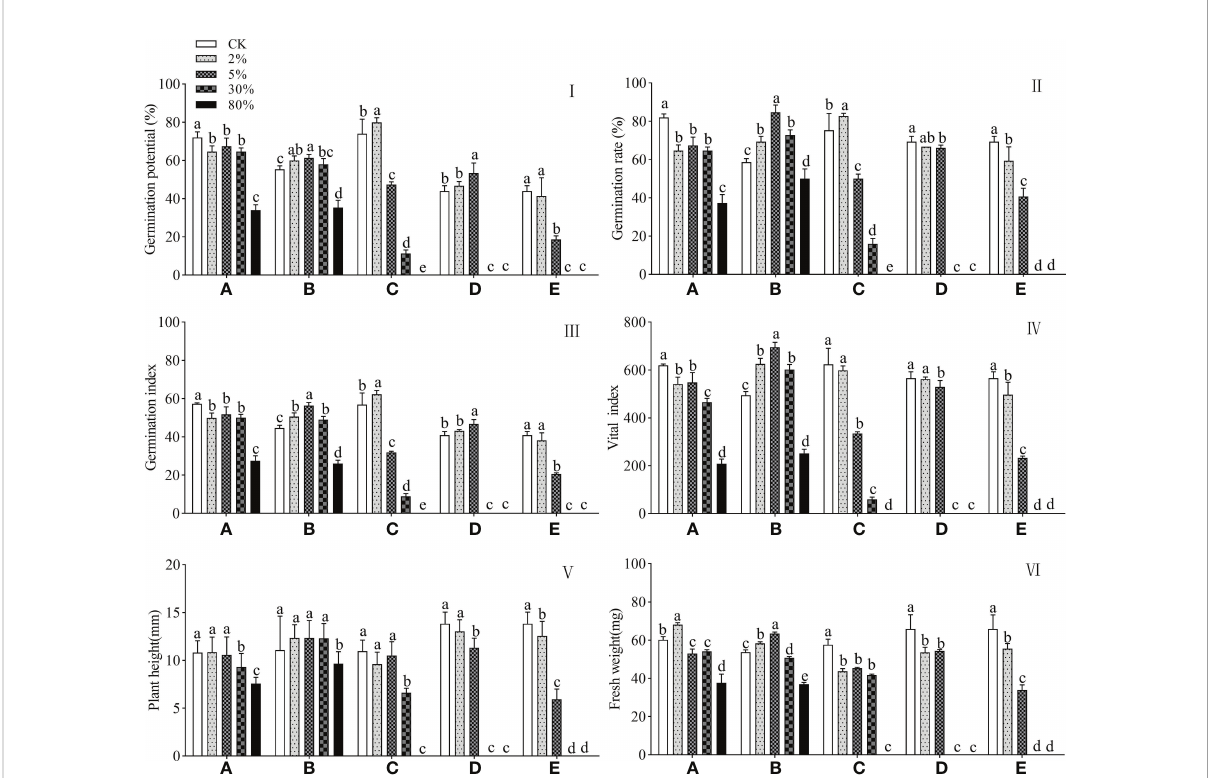
FIGURE 1 Effect of different identi fi ed substances on germination and growth of goosegrass. Different letters above each group of the bar chart denoted signi fi cantly different among different concentration treatments of identi fi ed substance at P < 0.05 by LSD test, respectively. Bars represent 10, 3, and 5 repetitions ± SD in plant height, fresh weight, and germination-related parameters, respectively. (A) 4-Ethylphenol. (B) Allyl isothiocyanate. (C) N-acrylimorpholine. (D) 2-Hydroxyethyl acrylate. (E) Mixture of (A-D)